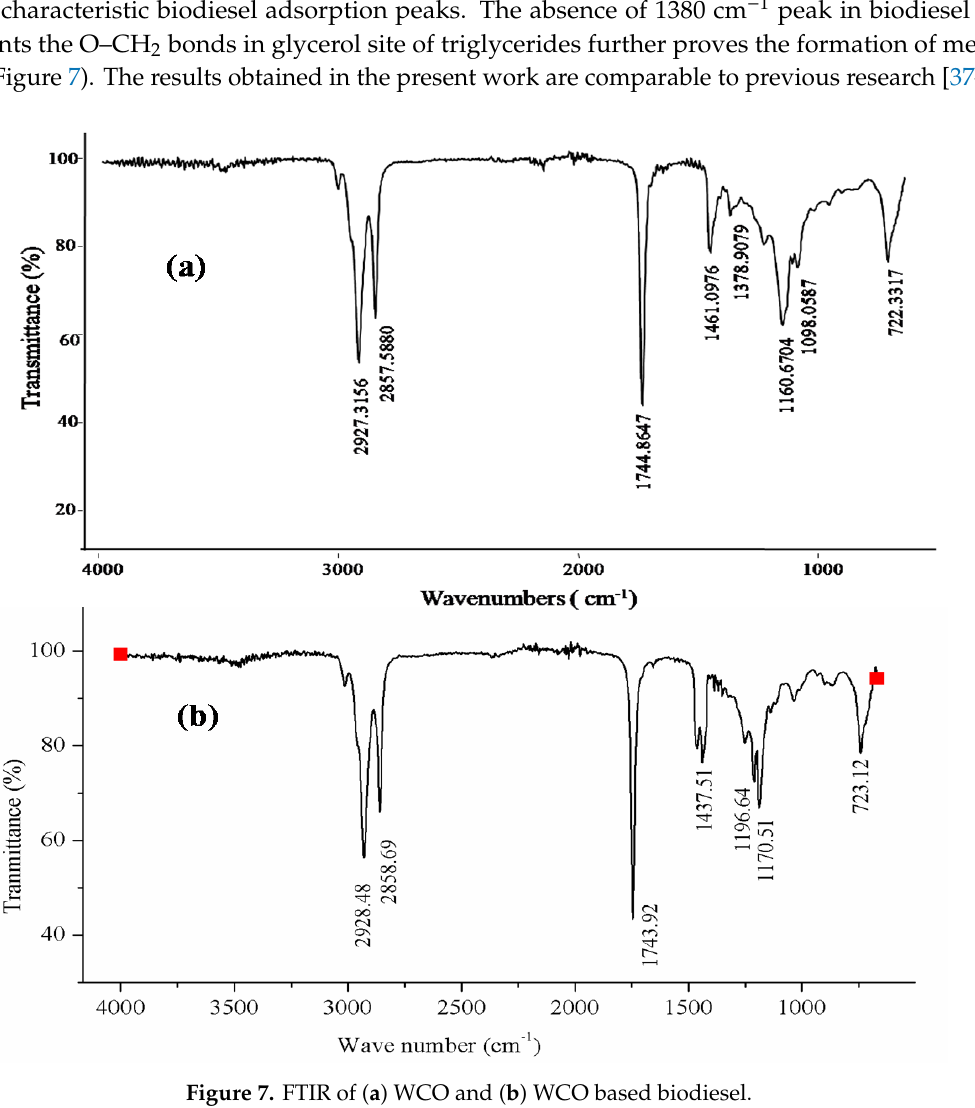
Figure 7. FTIR of ( a ) WCO and ( b ) WCO based biodiesel.